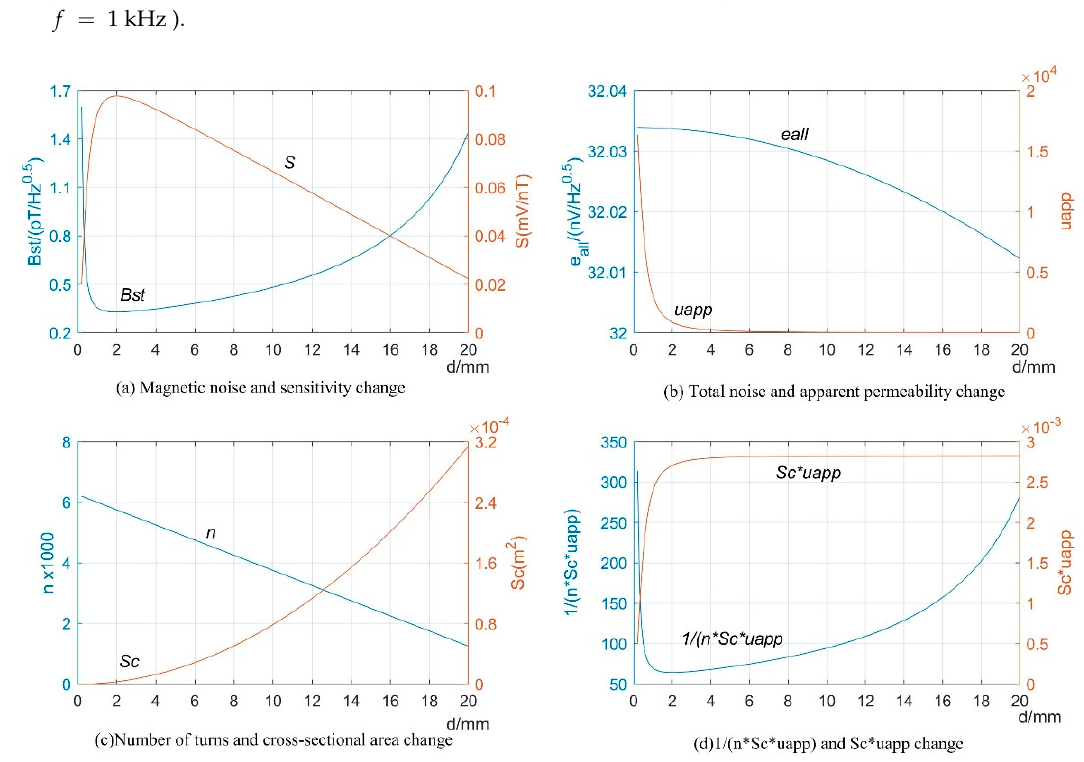
Figure 7. Relation curve between magnetic noise, sensitivity, total noise spectral density, apparent permeability, cross-sectional area 1/ nS c µ app , S c µ app , and core diameter d . The fixed parameter is d w = 0.2 mm, and other parameters are consistent with Figure 6.